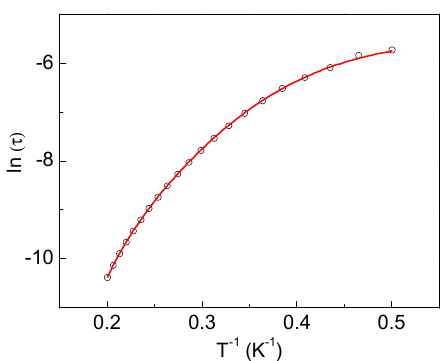
Figure 8. Magnetization relaxation time ln( τ ) vs. T − 1 plot under the optimal dc field of 1500 Oe for 4-Er . The solid red line represents the fit to Equation (11) with no contribution from the direct relaxation process (A = 0).